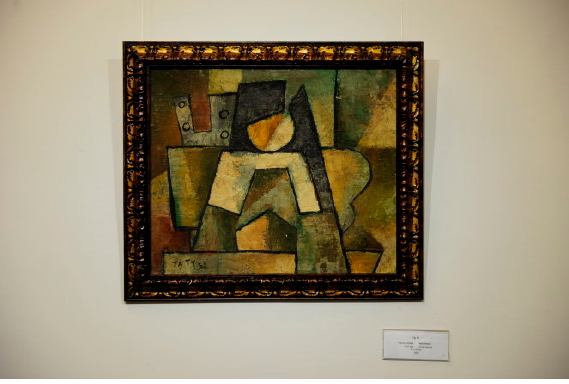
Figure 6. Truu Tuong —Thanh Chuong (signed Ta Ty). The image was sourced from Tuoi Tre Newspaper (Khoa 2016).